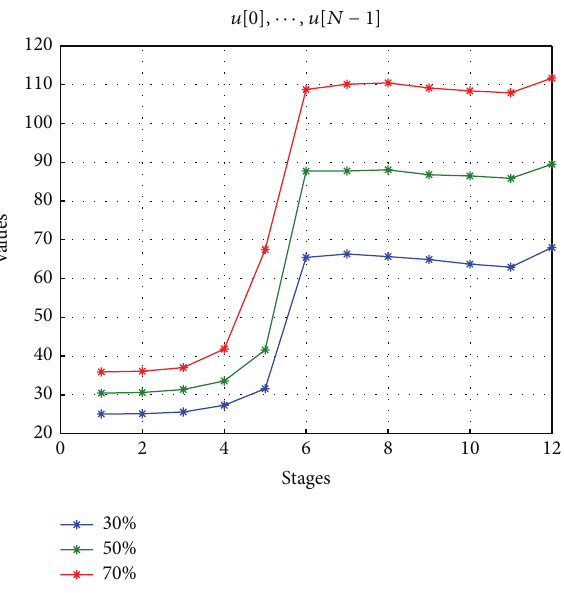
Figure 2: Case 1, band of values for first product optimal